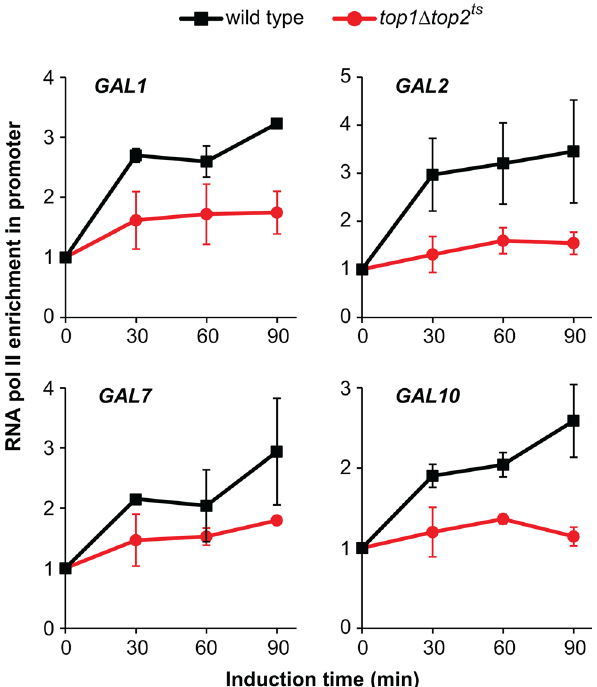
Fig 4. Topoisomerase activity is required for RNA polymerase II recruitment. ChIP analysis of RNA polymerase II enrichment in GAL gene promoters of wild type and top1 Δ top2 ts cells following transcriptional activation. Experimental setup was as described for Fig 1B, and ChIP was performed using antibodies targeting RNA polymerase II. RNA polymerase II binding levels were normalized relative to the binding under uninduced conditions at the 0 min time point (set to 1). Averages from two individual experiments are shown, and error bars represent ± one standard deviation. Positions of primers used in the ChIP experiments for the individual GAL genes are indicated with arrows in Fig